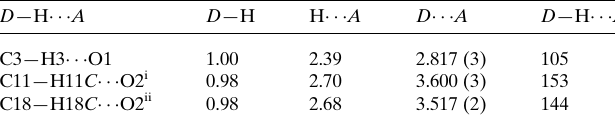
Table 1 Hydrogen-bond geometry (A˚ , (cid:2)